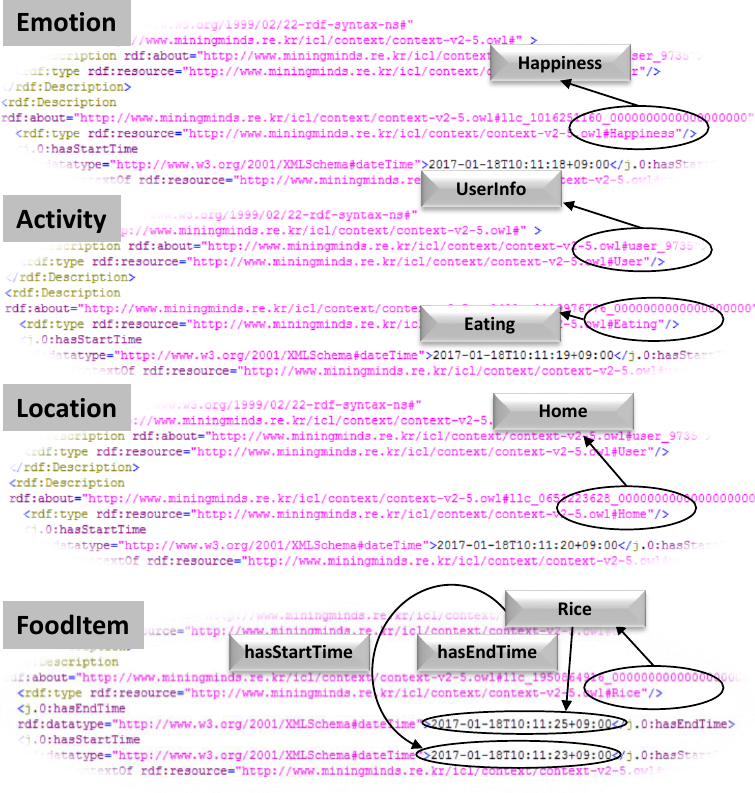
Figure 10. Context Synchronizer: Synchronizing low-level contexts w.r.t timestamps.